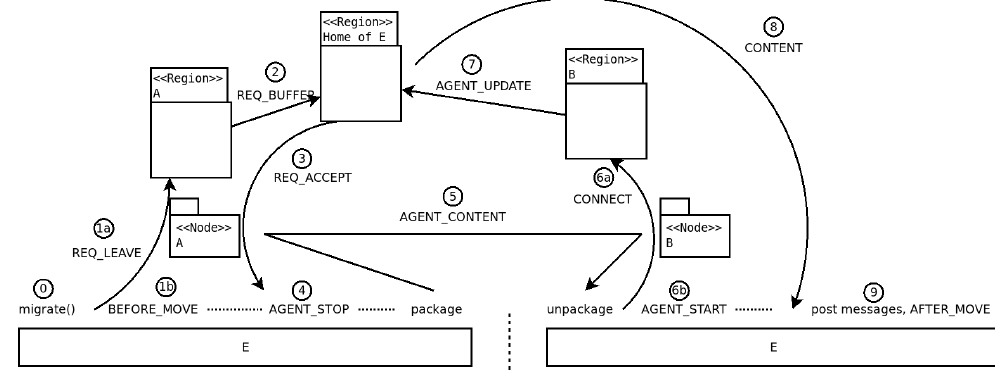
Figure 3. A representation of the process of migration of an entity between two regions of which none is its home region. The phases shown are presented in Sections 4.1.2 and 4.1.3.